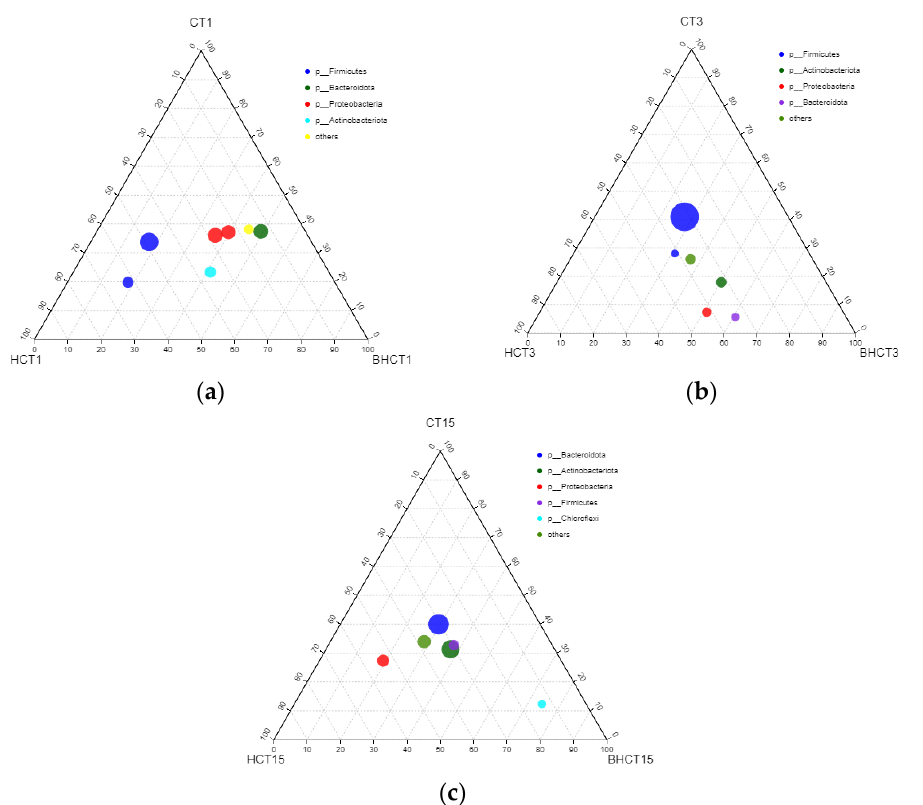
Figure 3. Ternary diagram at the phyla of the bacteria community among CT, BHCT, and HCT during three different composting stages: ( a ) Day1, ( b ) Day3, ( c ) Day15.